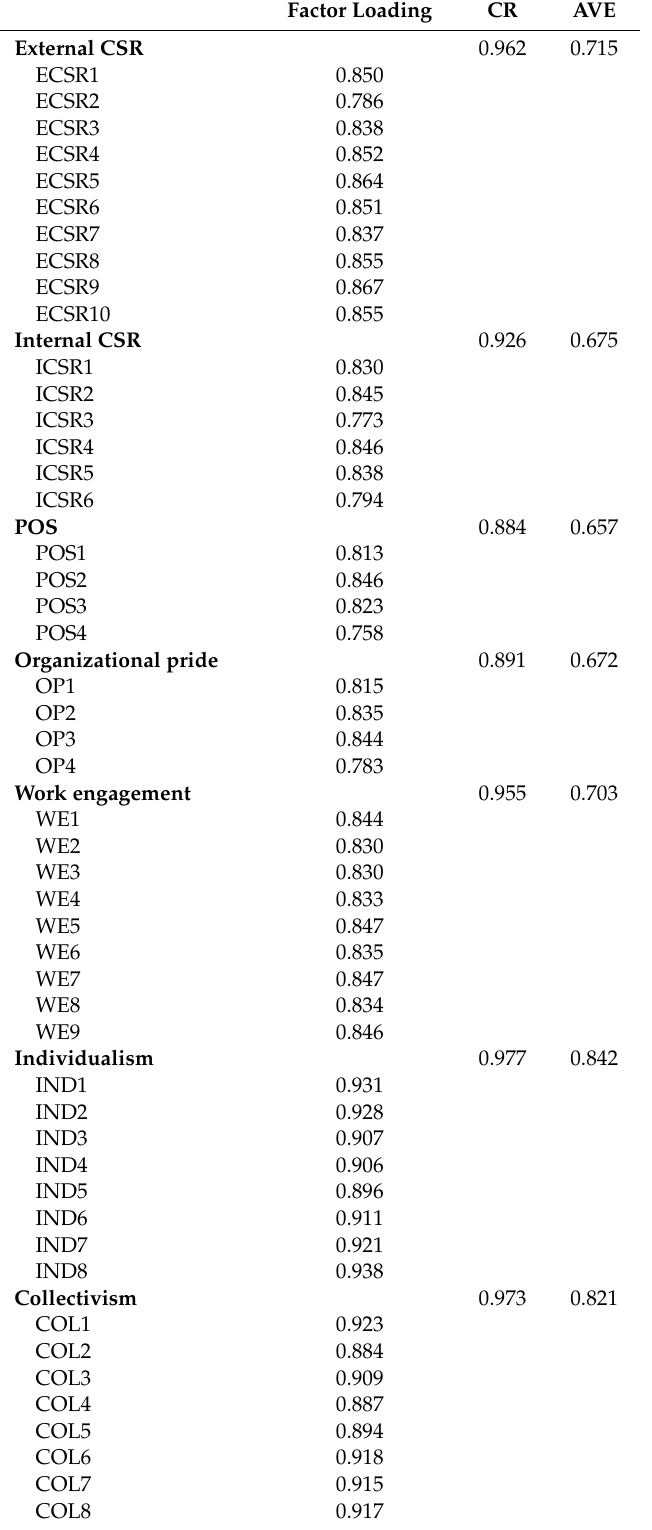
Table 1. Reliability and